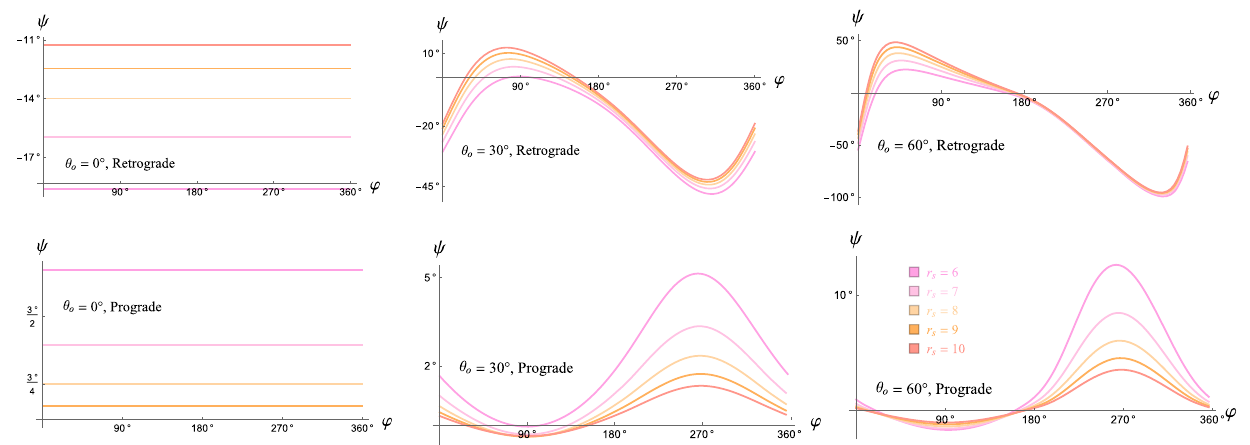
Fig. 6 The variation of ψ with respect to ϕ for primary images